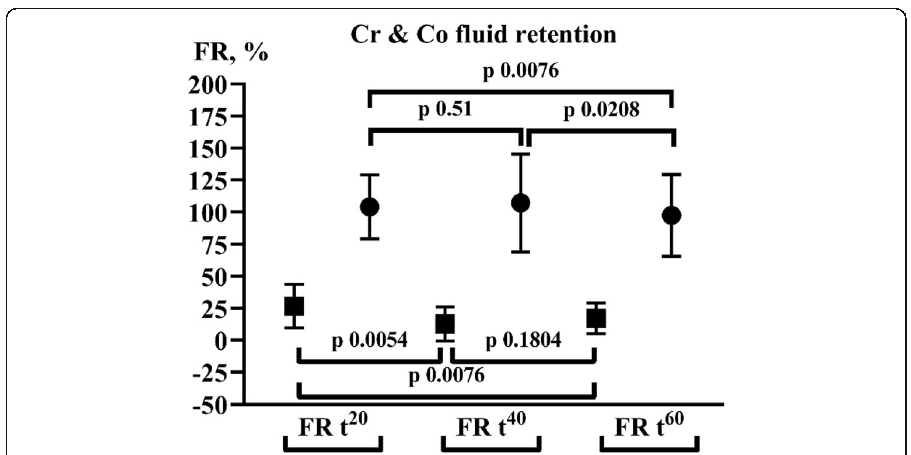
Fig. 3 Fluid retention after one, two and three 20 min periods in the crystalloid (Cr, full square) and colloid (Co, full circle)